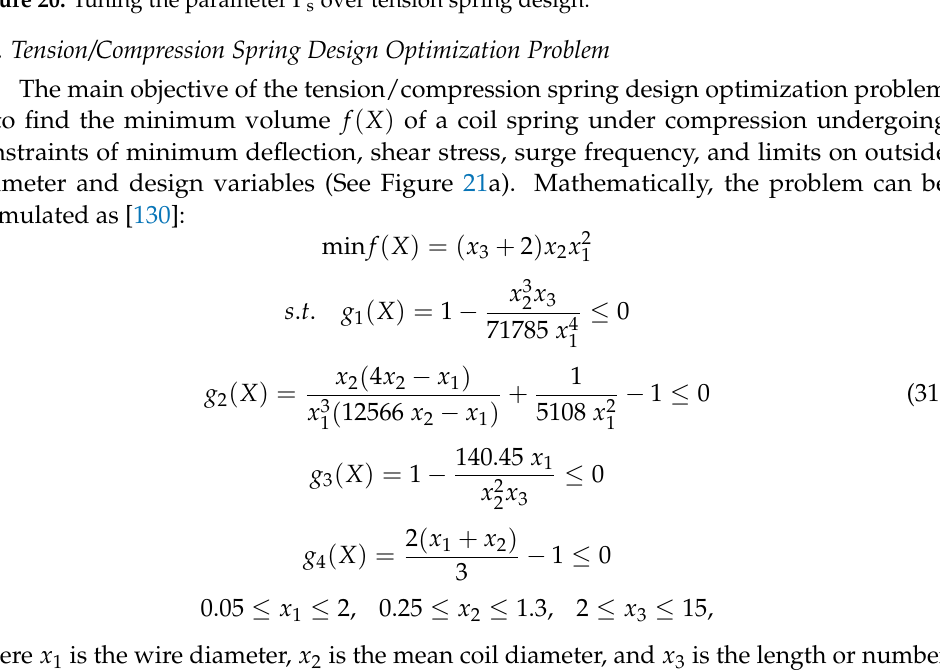
Figure 20. Tuning the parameter P s over tension spring design.